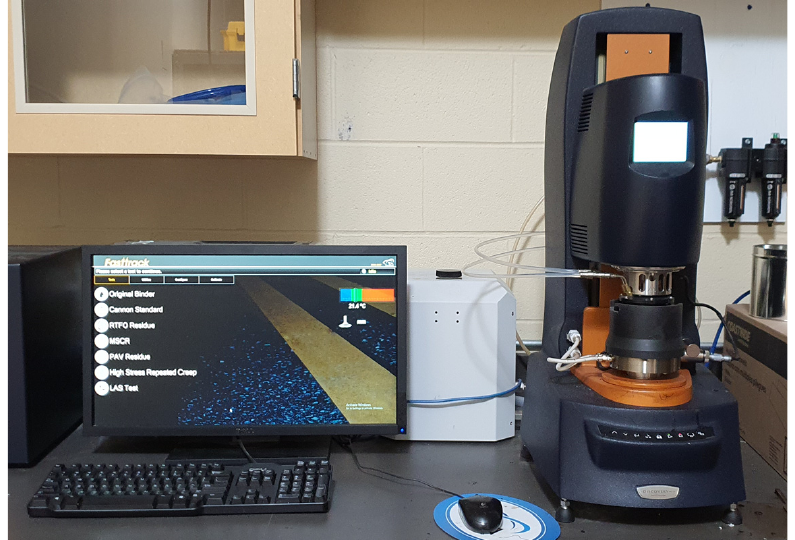
Figure 6. The dynamic shear rheometer.